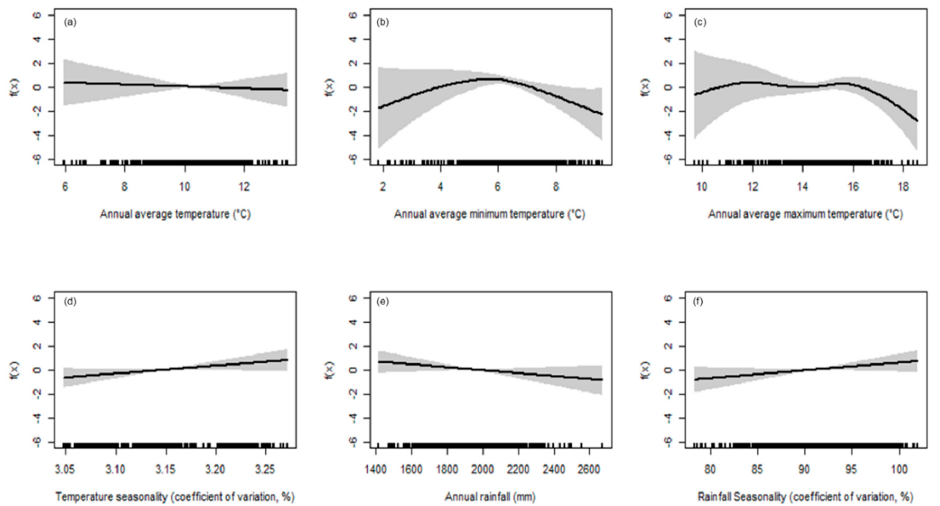
Figure 7. Generalized additive models for s pecies diversity distributions along climatic variables ((a) annual average temperature, (b) annual average minimum temperature, (c) annual average maximum temperature, (d) temperature seasonality, (e) annual rainfall, and (f) rainfall seasonality). Marks along the x-axis represent individual sample points. The function of species diversity (i.e., f(x)) is expressed in mean deviation form. Grey shading represents 95% confidence intervals. Continuous lines represent smoothing curves.